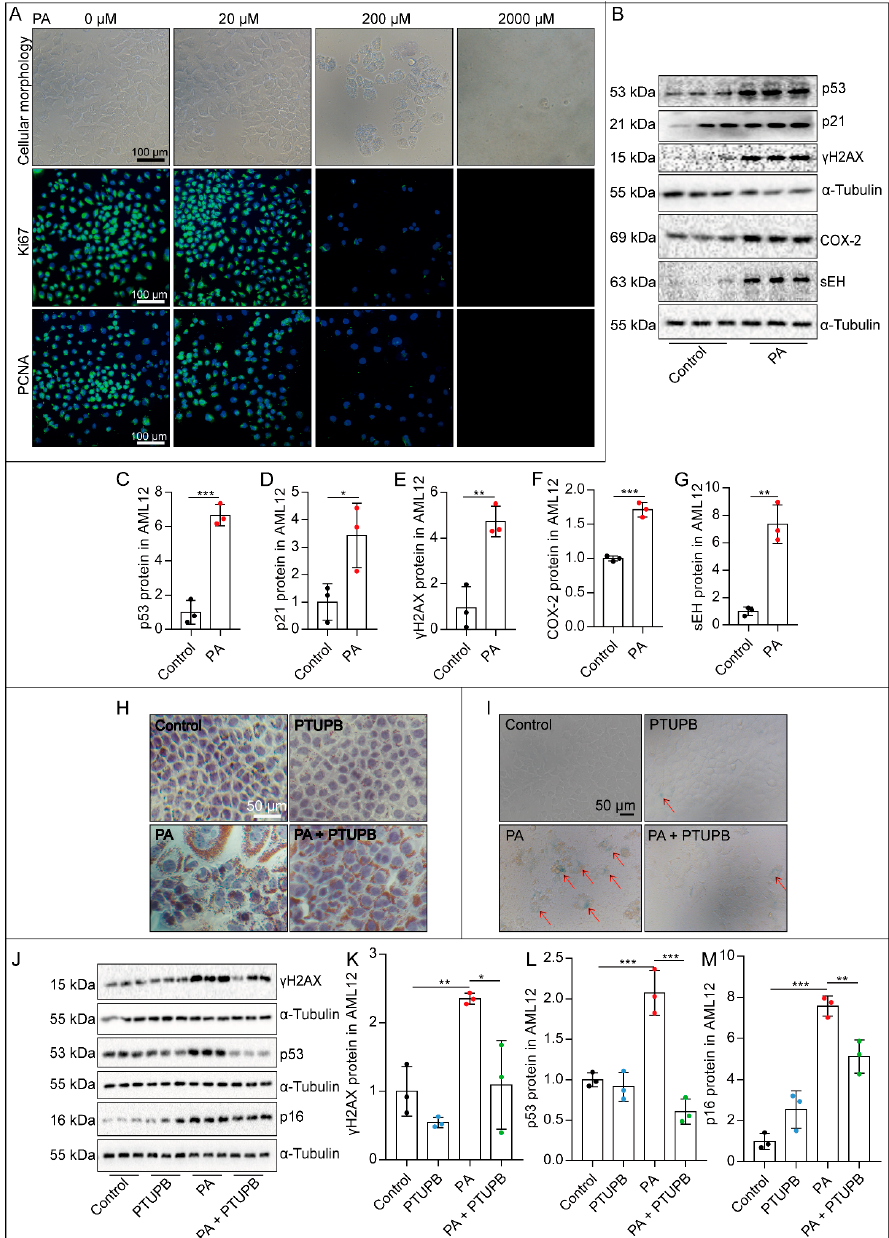
Figure 3. PTUPB attenuates PA-induced hepatocyte senescence in vitro . AML12 cells were treated with a series of concentrations of PA (0, 20, 200, and 2000 μ M) for 48 h, and then the changes in cell